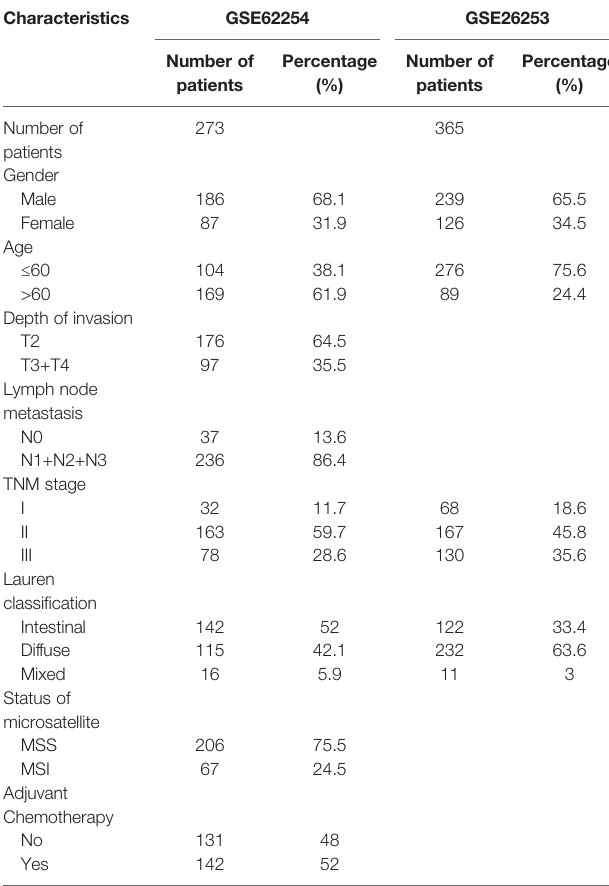
TABLE 1 | Characteristics of patients in the training (GSE62254) and testing (GSE26253) cohorts.